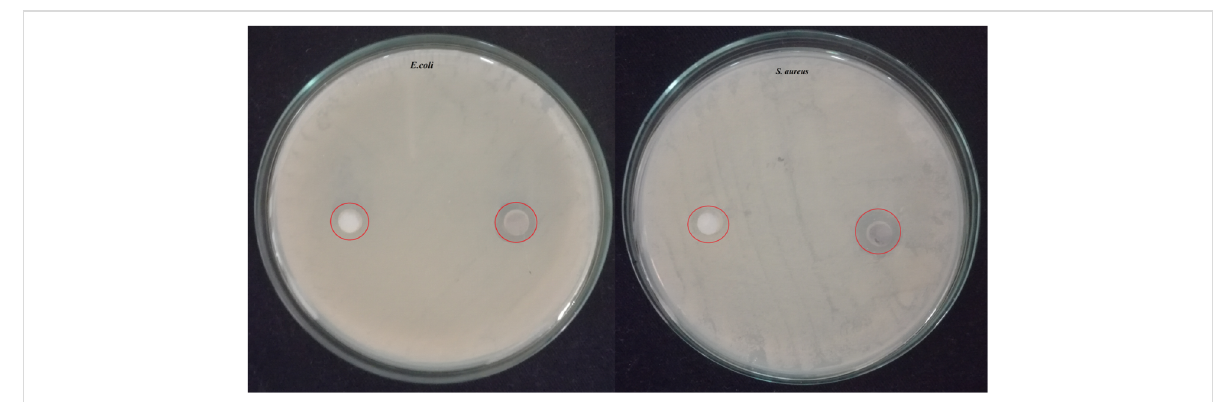
Figure 6: Antibacterial activity of hydroxyapatite (Hap) nanorods using cuttlefish bone powder as a precursor (CB-Hap NRs).